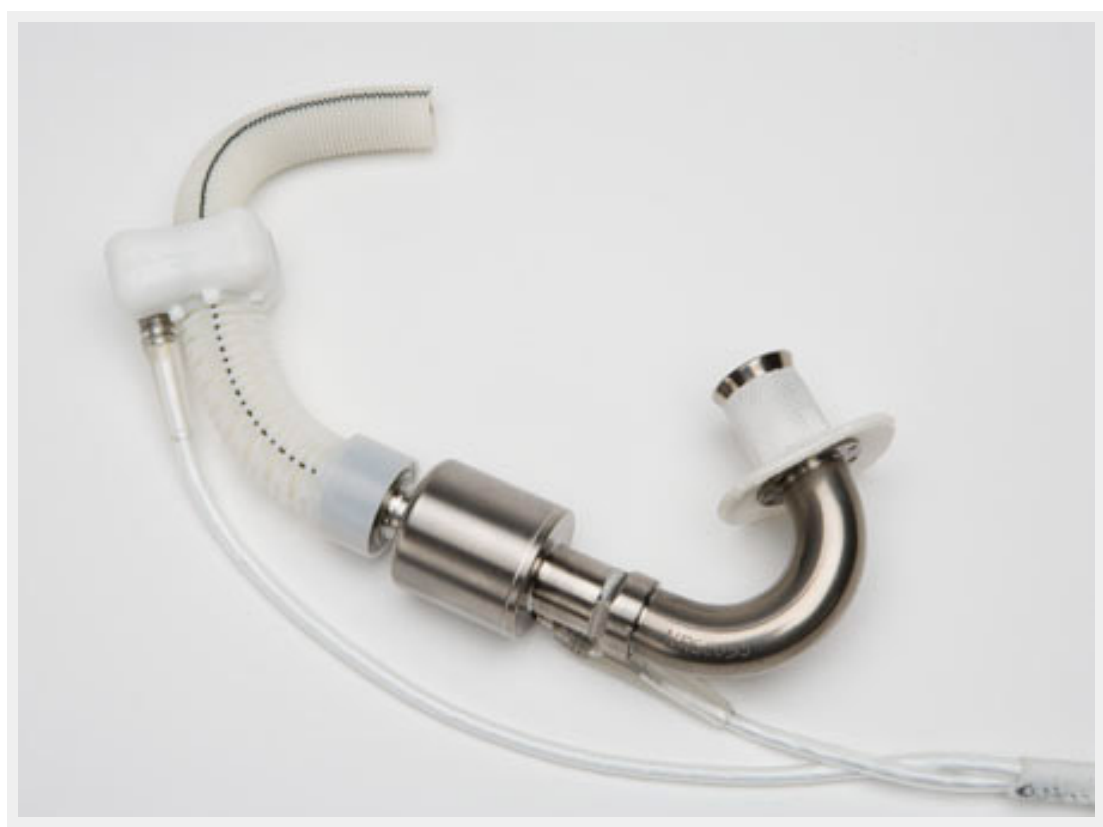
Figure 4 The HeartAssist 5 (MicroMed Technology Inc, Houston, TX) formerly known as DeBakey Child, usable in children down to 5 years, is the only ventricular assist device measuring the actual flow using a flow probe. (http://www.micromedcv.com/united_states/heart-assist-5/